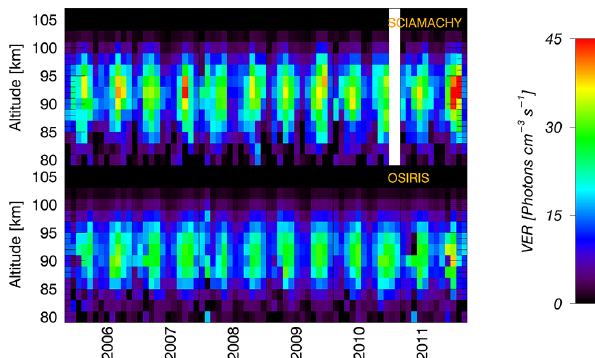
Figure 6. VER after inversion of LERs from SCIAMACHY and OSIRIS Na D-line nighttime limb measurements which are shown in shown in Fig. 5. Both instruments detect a semi-annual cycle with peaks in the spring and fall months. The white regions are pre- viously filtered regions with a low